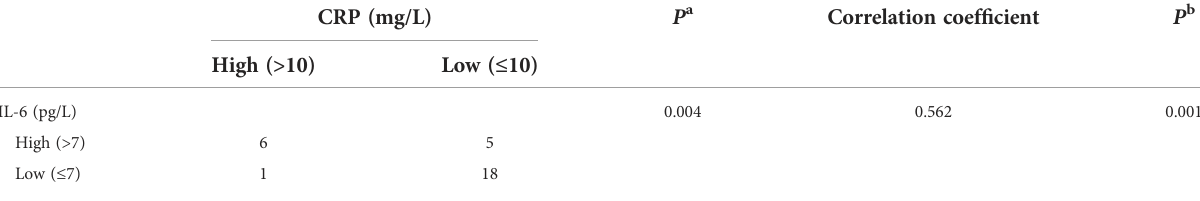
TABLE 4 Correlation between IL-6 and CRP levels in patients with mPC treated with